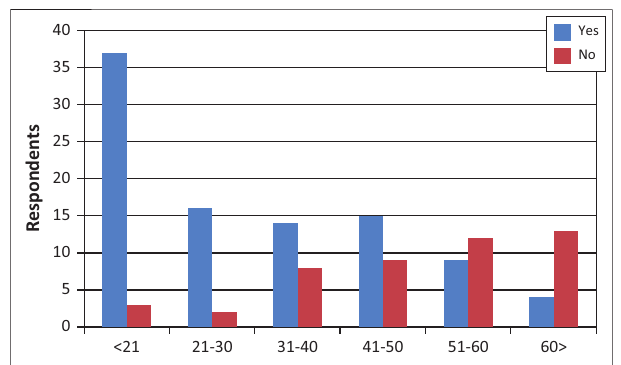
FIGURE 9: Age of respondents and willingness to access the church website via cellular